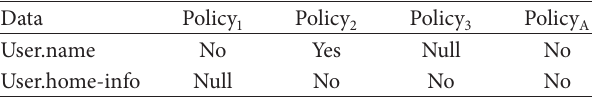
Table 4: Required values of Purpose values in Service A. Purpose Policy Policy Policy Policy 1 2 3 A Current Always Always Null Always Telemarketing Null Always Always Always Table 5: Required values of Recipient values in Service A. Recipient Policy Policy Policy Policy 1 2 3 A Same Null Null Always Always 3 user.home-info Null Opt-out Unrelated 2 user.home-info